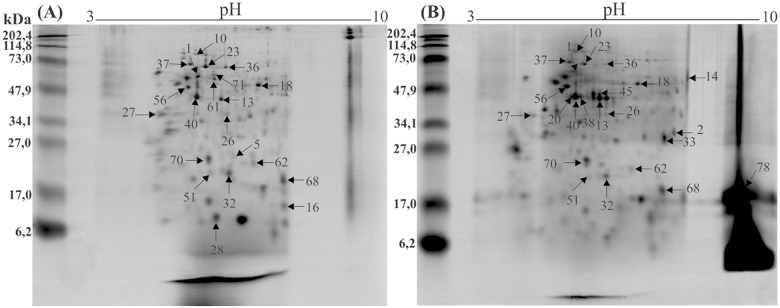
Representative 2-D electrophoresis proteins profile from Dufour’s gland of Apis mellifera nurse (A) and forager (B) workers.All identified proteins by MALDI-TOF/TOF are numbered and spot numbers correspond to Table 1.